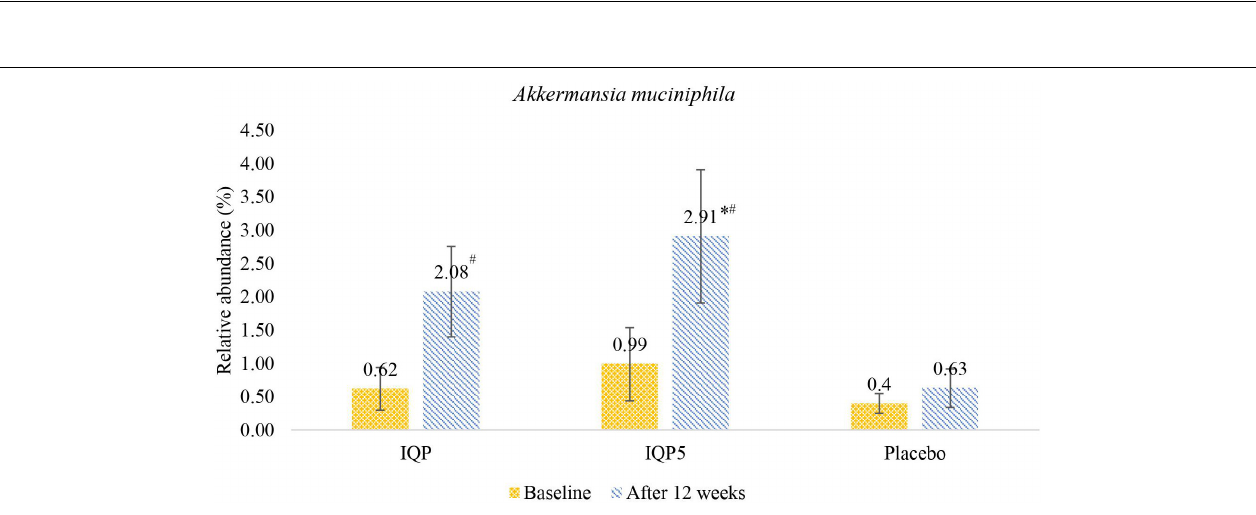
FIGURE 4 | Relative abundance presented in percentage (%) of Akkermansia muciniphila in the IQP, IQP5, and placebo groups at baseline and after 12 weeks; ∗ p < 0.05 compared with placebo after 12 weeks. # p < 0.05 compared with baseline within the same groups.